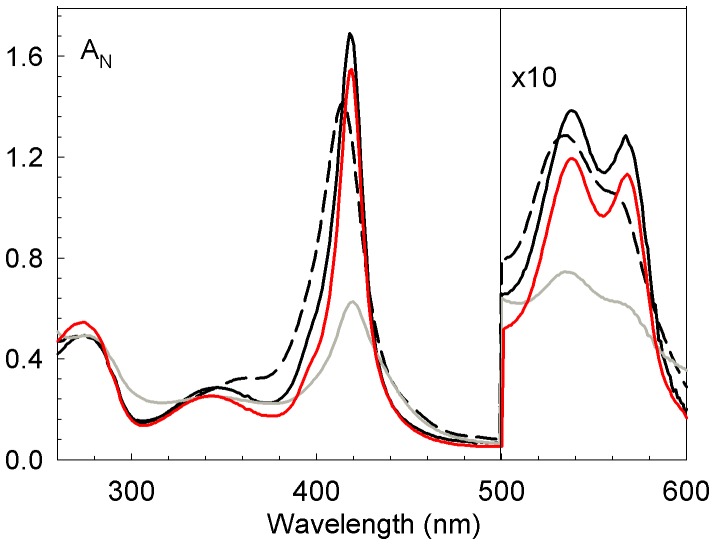
Absorption spectra of truncated AHSPWT/α-Hbs complexes.The spectra are represented in black for AHSPWT/α-HbWT complex, in red for of AHSP/α-Hb1-138 complex, in black dashed line for AHSP/α-Hb1-134 complex and in grey for AHSP/α-Hb 1-126 complex. The measurements were performed in PBS pH 7.4 at 25°C.